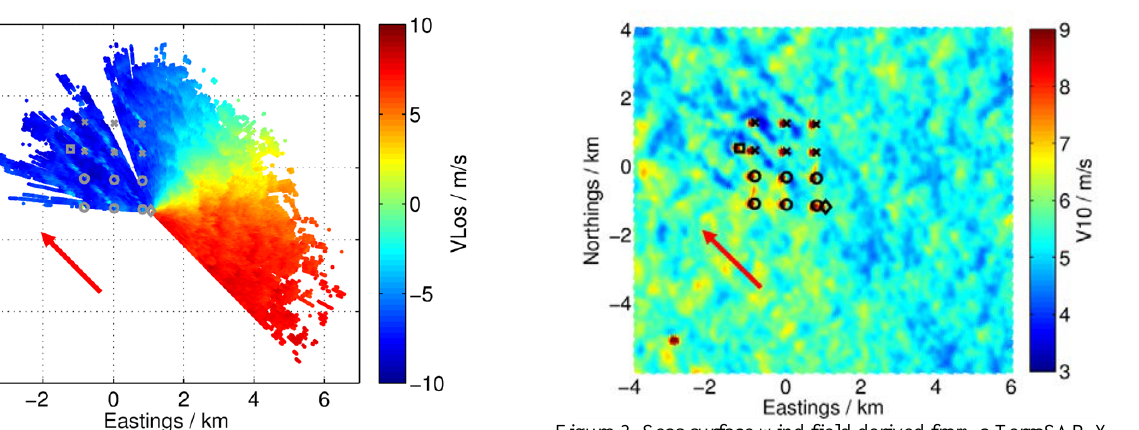
Figure 3. Seas surface wind field derived from a TerraSAR-X StripMap scene over alpha ventus, January 22, 2014. The red arrow illustrated the wind direction based on